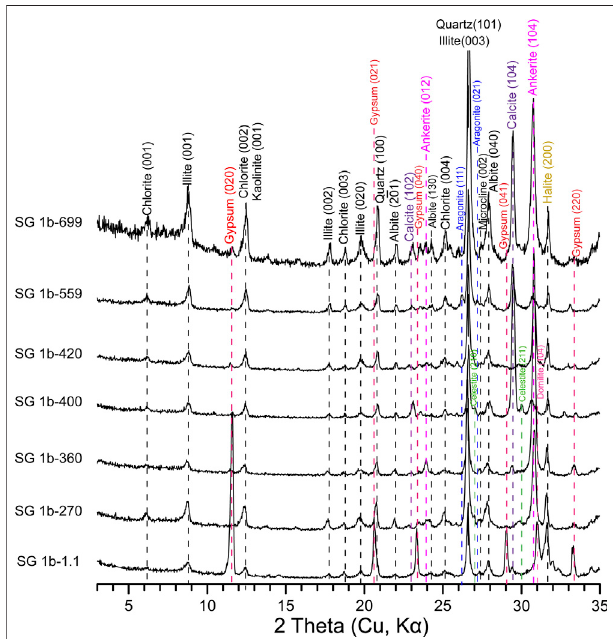
FIGURE 3 | X-ray diffraction patterns of sedimentary minerals from representative samples of the SG-1b core. Note that mica minerals and illite are marked as